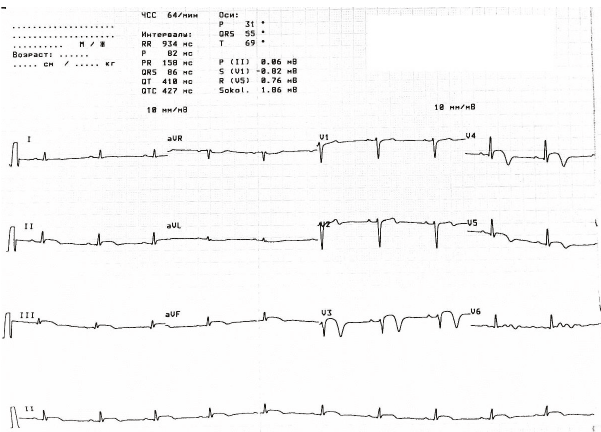
Figure 1: Electrocardiogram revealed a sinus rhythm with a 2 mm ST elevation in leads II, III, aVF, V3-V5, “ - ” and T V3-V5.